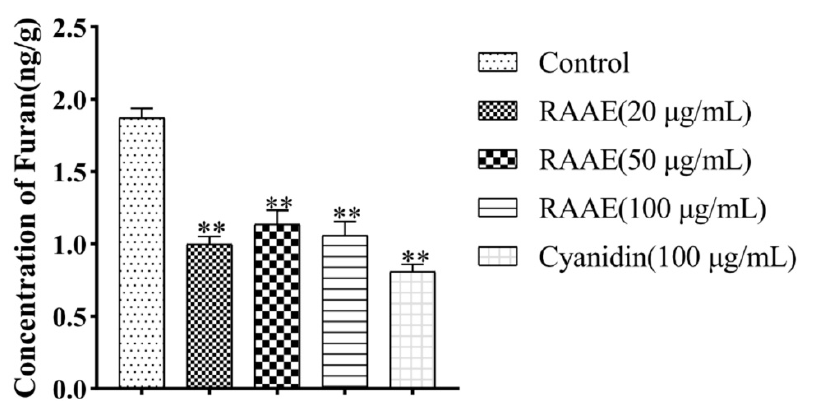
Figure 6. The reduction effect of RAAE on furan content in simulated solution in the Maillard model system. ** means p < 0.01 vs. control group.